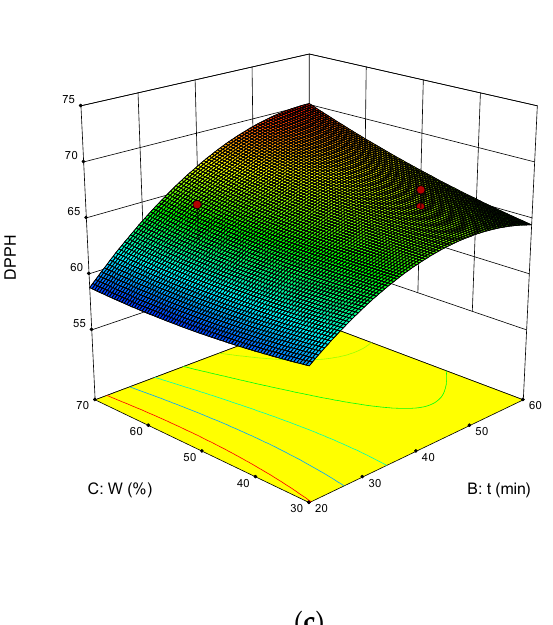
Figure 7. Response contour plots ( a – c ) showing the extraction temperature (A), extraction time (B), and water content (C) effect on the extraction yield of DPPH. Table 5. Chemical components of volatile compounds from extracts of Chamaenerion angustifolium (L.) Scop. analyzed by GC-MS.